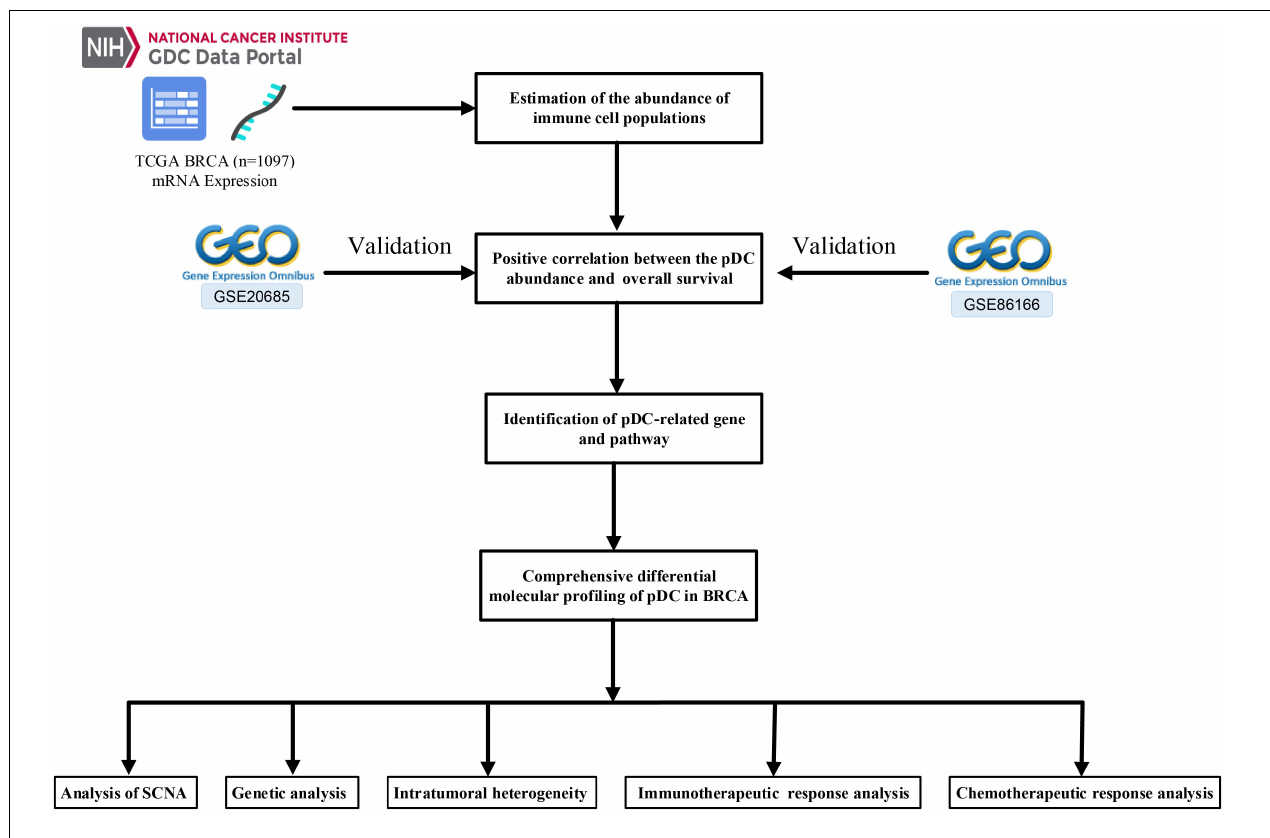
FIGURE 1 | Schematic presentation of the study